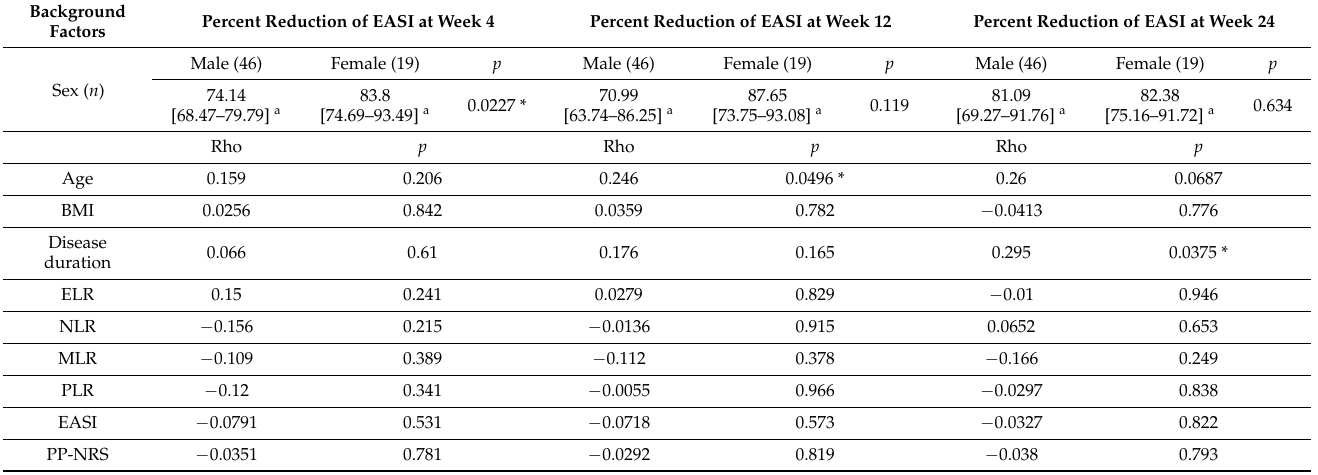
Table 4. The relations of patients’ background factors with the percent reduction of EASI at weeks 4, 12, or 24 of upadacitinib treatment for patients with atopic dermatitis ( n =